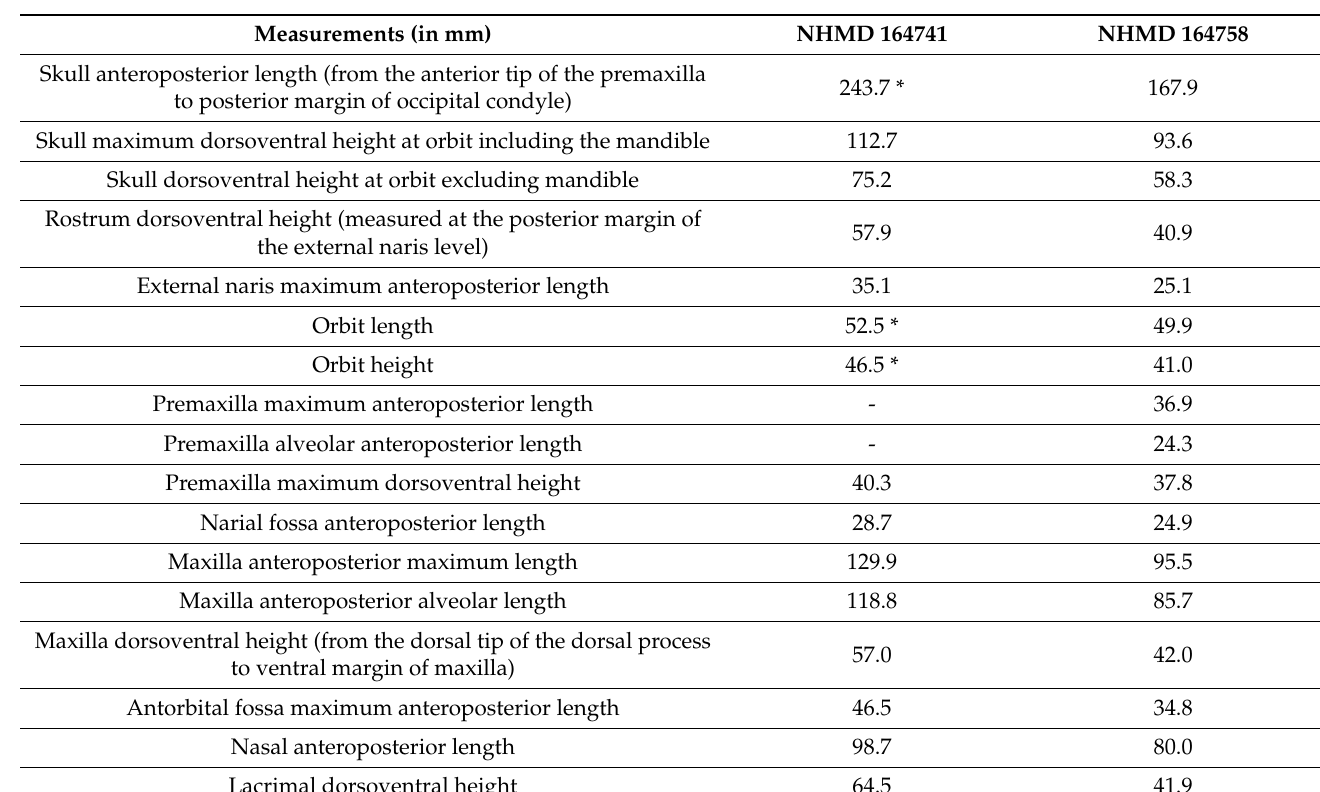
Table 2. General skull measurements for the Greenland specimens NHMD 164741 and NHMD 164758. Asterisk (*) indicates maximum preserved